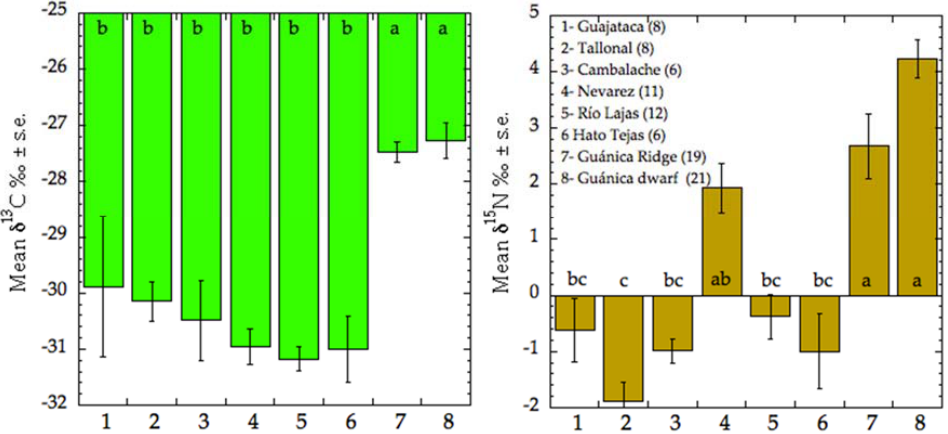
Figure 6. Average ± SE. values of N and C isotopes in adult leaves from different karst forests in Puerto Rico. Columns with the same letter at the base indicate statistical similarity (Tukey Honest Significant Difference, p = 0.01).